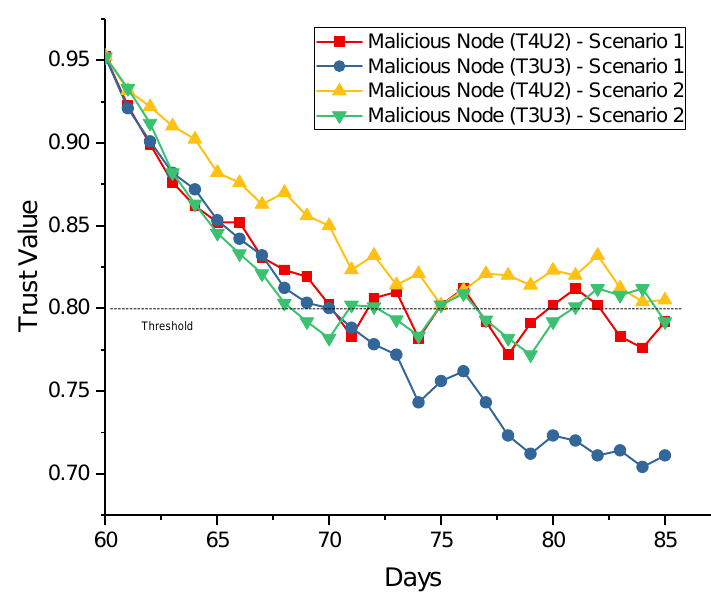
Figure 7. Trust value of malicious node under different scenarios in a real